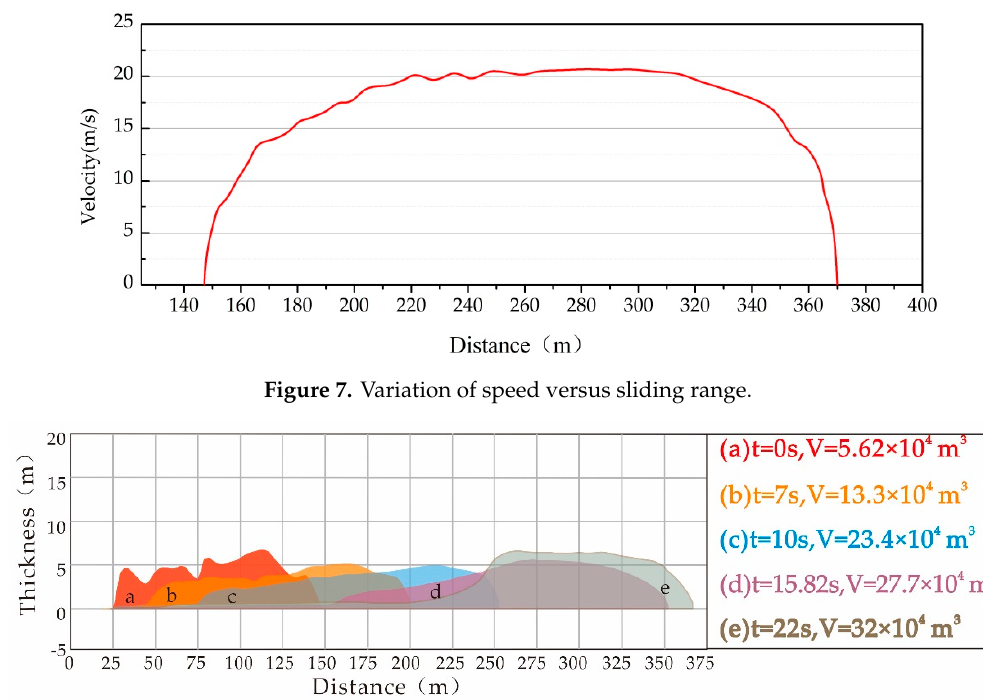
Figure 7. Variation of speed versus sliding range.